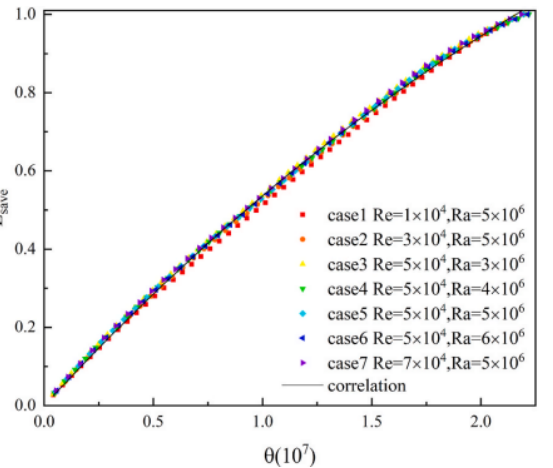
Figure 30. Fitting curves to thermal energy storage fractions in all situations. Reprinted with permission from Ref. [52]. 2021, Elsevier.